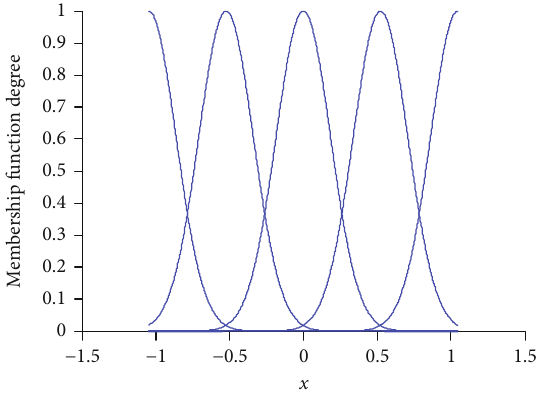
Figure 5: Membership function of x